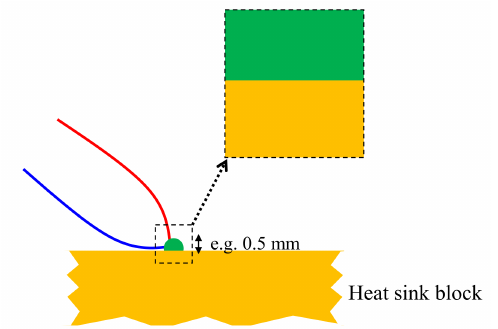
Figure 5. Thermocouple junction integrated with the surface of the copper block.